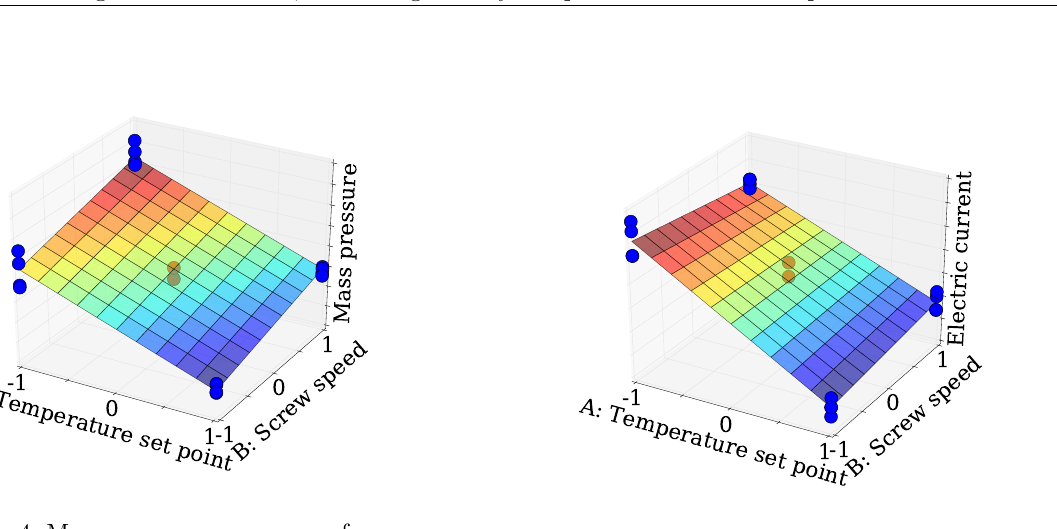
Figure 6: Electric current response surface